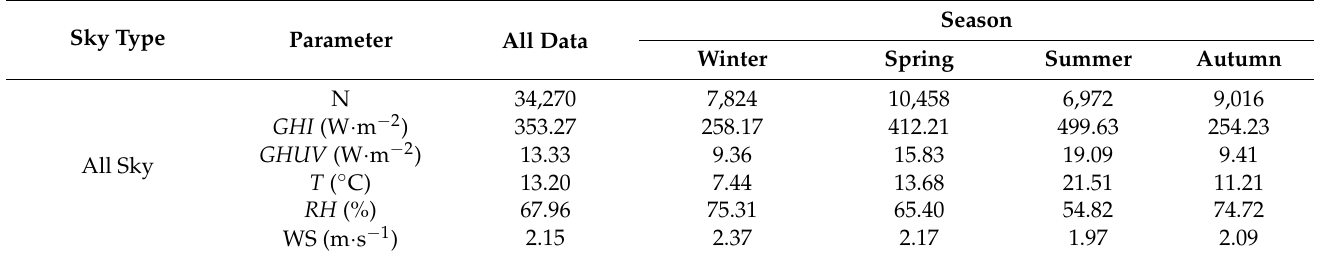
Table 5. Seasonal 10 min mean values (N) between 14 September 2020 and 6 June 2022 for global solar irradiance ( GHI ), global ultraviolet irradiance ( GHUV ), air temperature ( T ), relative humidity ( RH ), and wind speed ( WS ), for overcast, intermediate, and clear sky conditions classified in accordance with the k t